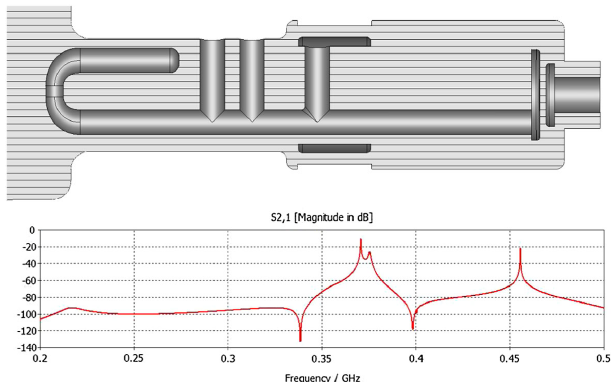
FIG. 25. LOM coupler geometry (top) and transmission spec- trum